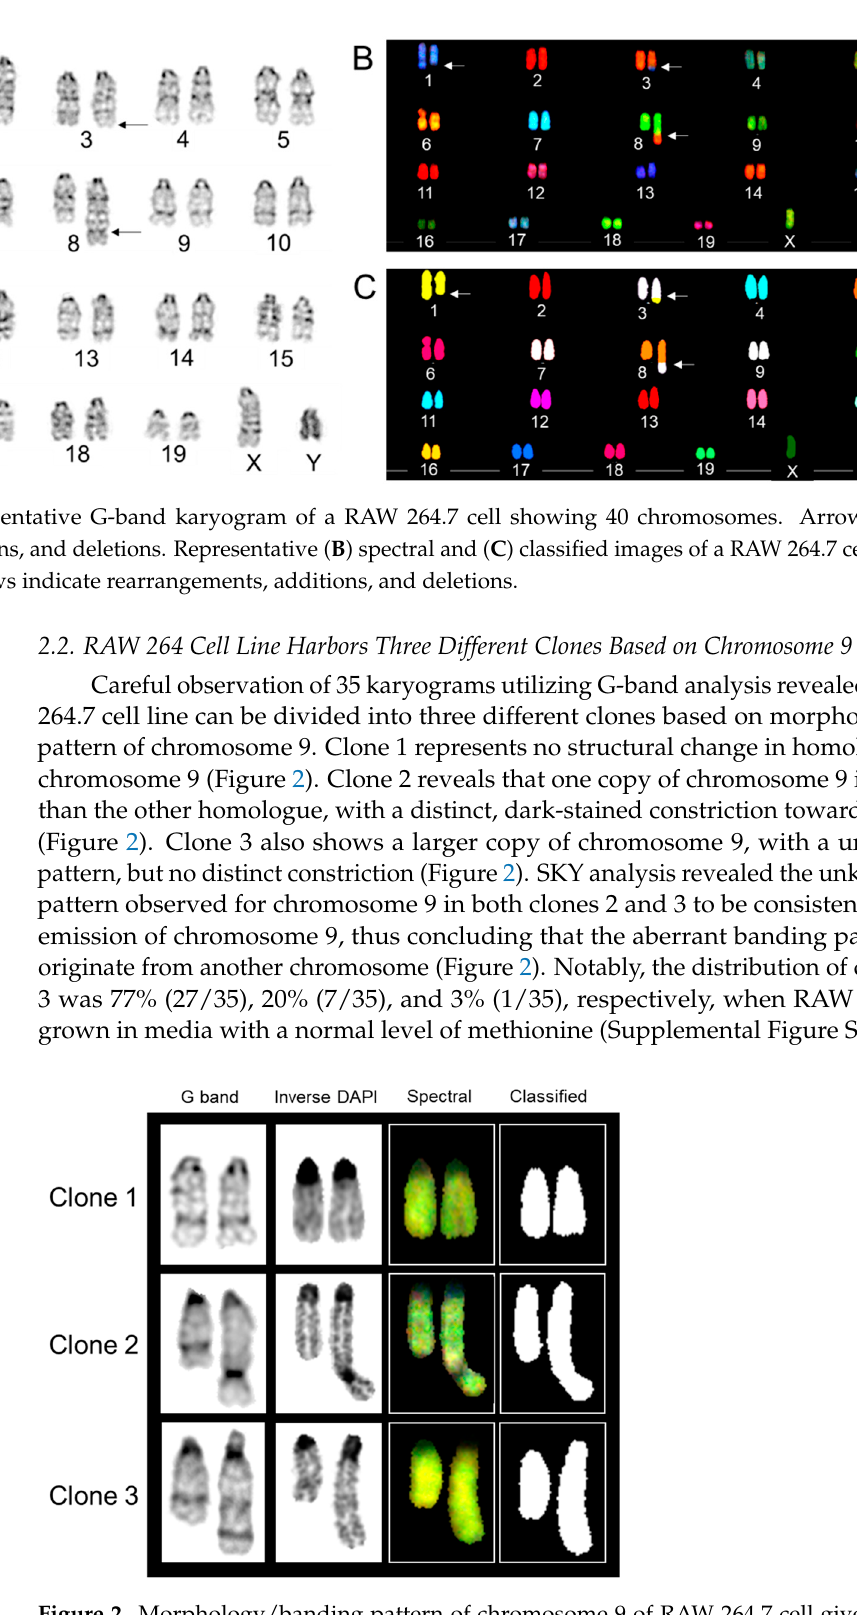
Figure 2. Morphology/banding pattern of chromosome 9 of RAW 264.7 cell gives rise to 3 separate clones.